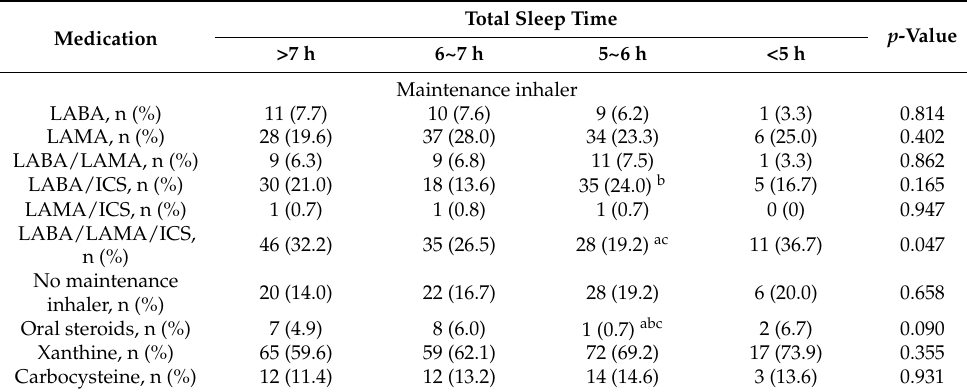
Table 4. Medication from four groups according to total sleep time.